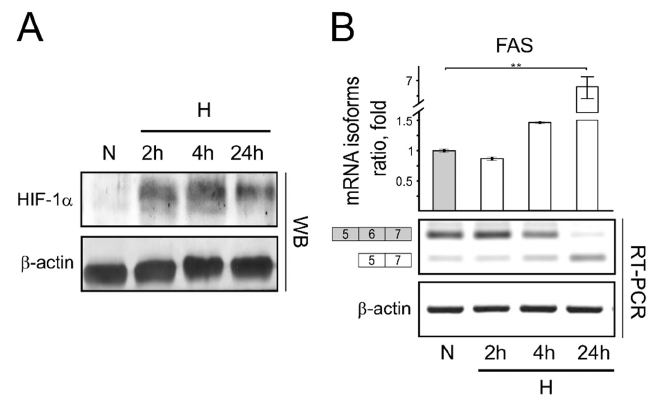
Figure 1. FAS exon 6 splicing pattern in short-term (2 h, 4 h) and long-term (24 h) hypoxia. ( A ) HIF-1 α protein cellular levels. ( B ) Reverse transcriptase PCR (RT-PCR) results of endogenous FAS/sFAS mRNA expression ratio in normoxic and hypoxic cells. Bar plot represents the quantification of FAS/sFAS isoform ratio of 3 independent experiments. The FAS/sFAS isoform expression ratio calculated in cells grown under normal oxygen conditions is taken as 1. Error bars represent the amount of spread between the extremes of the data, ** p < 0.05. N—cells cultivated under normal conditions; H—cells cultivated under hypoxic conditions for indicated time.